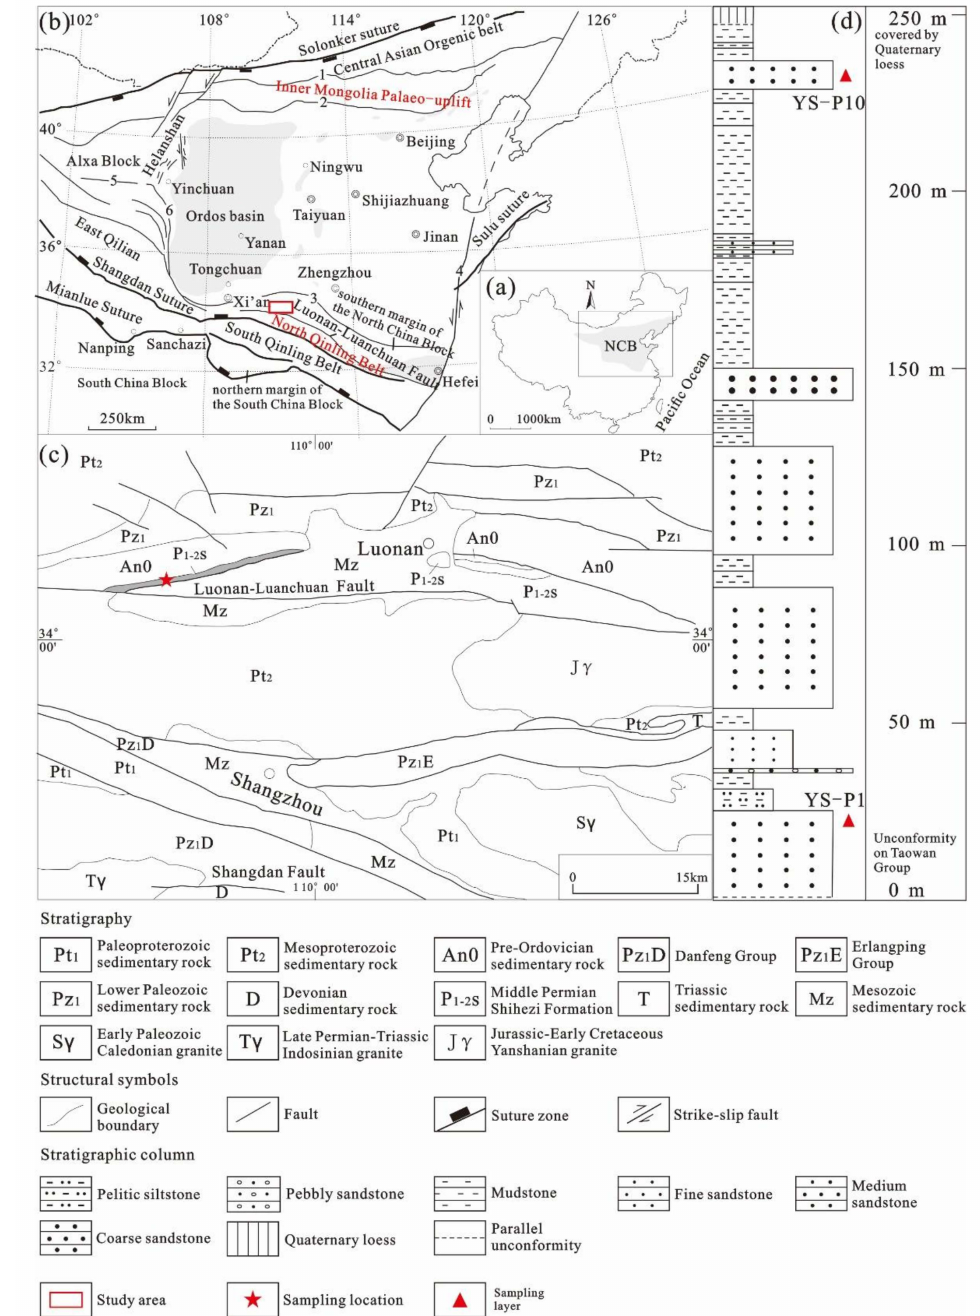
Figure 1. ( a ) Inset showing the location of North China Block (NCB) in China; ( b ) tectonic map of North China Block and its adjacent areas (modified from Liu [43]); 1 Chifeng–Bayan Obo fault; 2 Jining–Longhua fault; 3 Lingbao–Lushan–Wuyang fault; 4 Tanlu fault; 5 Longshoushan fault; 6 Baoji–Guyuan fault; ( c ) geological map of Luonan (modified from Chen [44]); gray area represents the study area; ( d ) stratigraphic column of Shihezi